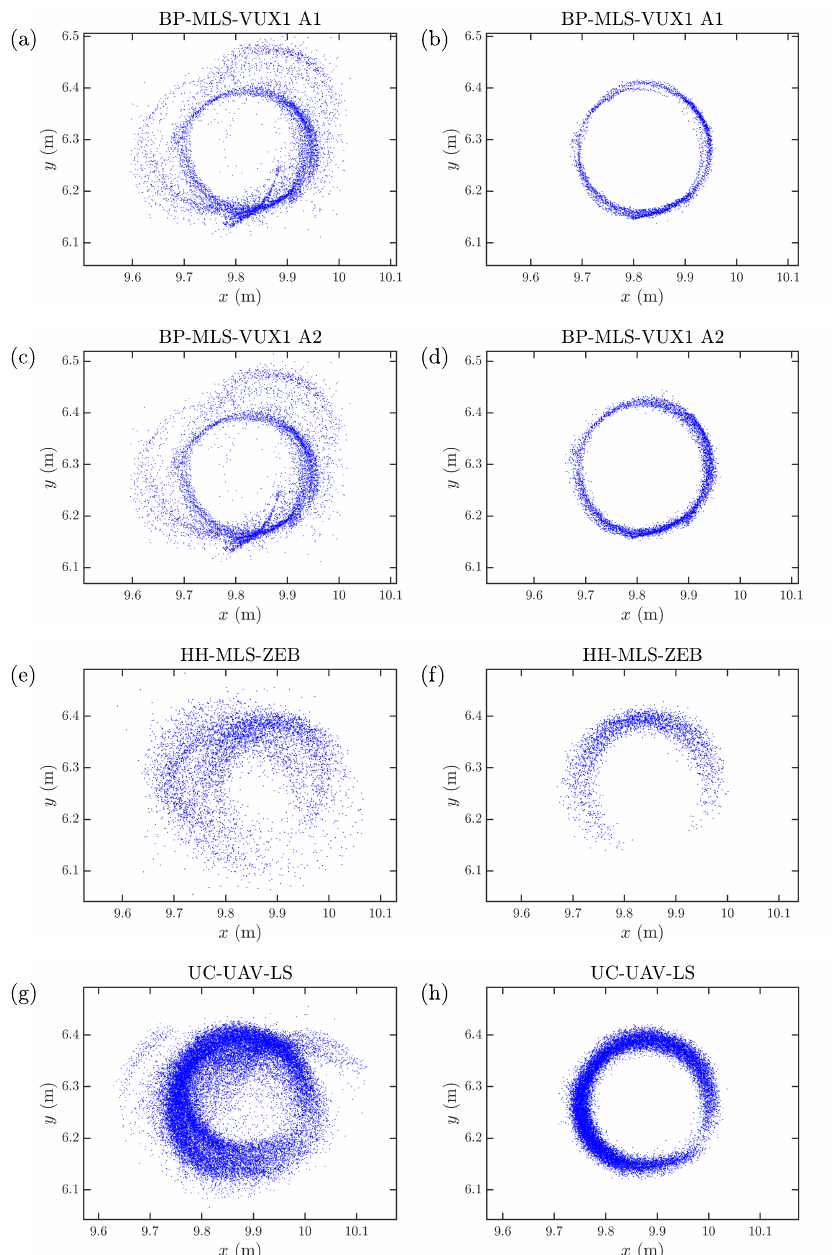
Figure 7. ( a , c , e , g ) Cross section of the SLAM-corrected point cloud modeling a pine tree in the height range z ∈ [ 2.0 m,2.5 m ] m collected with ( a , c ) the backpack BP-MLS-VUX1 system, ( e ) the handheld HH-MLS-ZEB system, and ( g ) the under-canopy UC-UAV-LS system. Note that the panels ( a , c ) are essentially the same figure. ( b , d , f , h ) The corresponding pine stem models after applying the arc extraction algorithm and the iterative arc matching algorithm ( b ) for the data collected with the backpack BP-MLS-VUX1 system and processed using the 2D arc extraction algorithm (A1), ( d ) for the data collected with the backpack BP-MLS-VUX1 system and processed using the 3D arc extraction algorithm (A2), ( f ) for the data collected with the handheld HH-MLS-ZEB system and processed using the 3D arc extraction algorithm, and ( h ) for the data collected with the under-canopy UC-UAV-LS system and processed using the 3D arc extraction